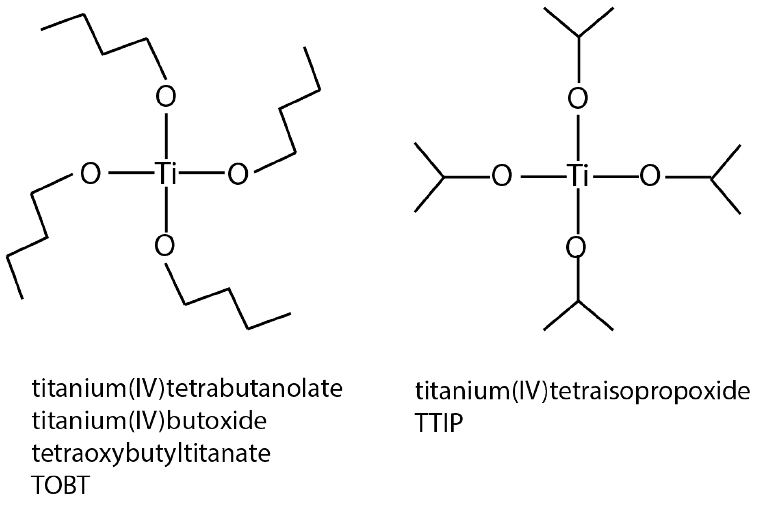
Figure 8. Common titania sol-gel